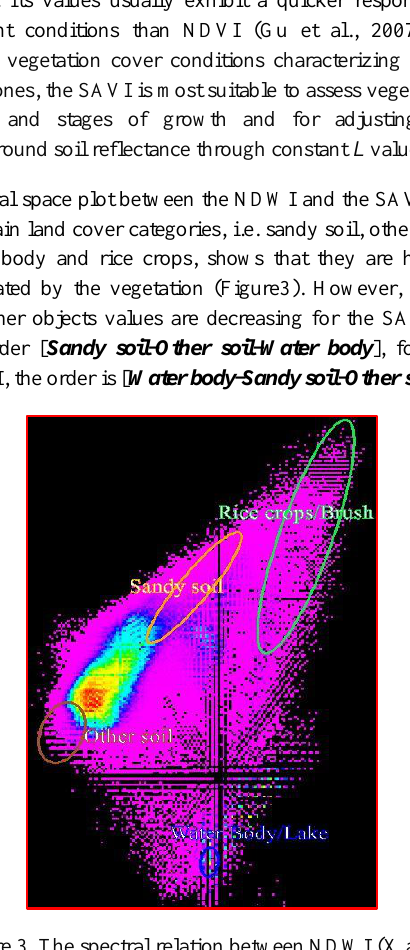
Figure 3. The spectral relation between NDWI (X axis) and SAVI (Y